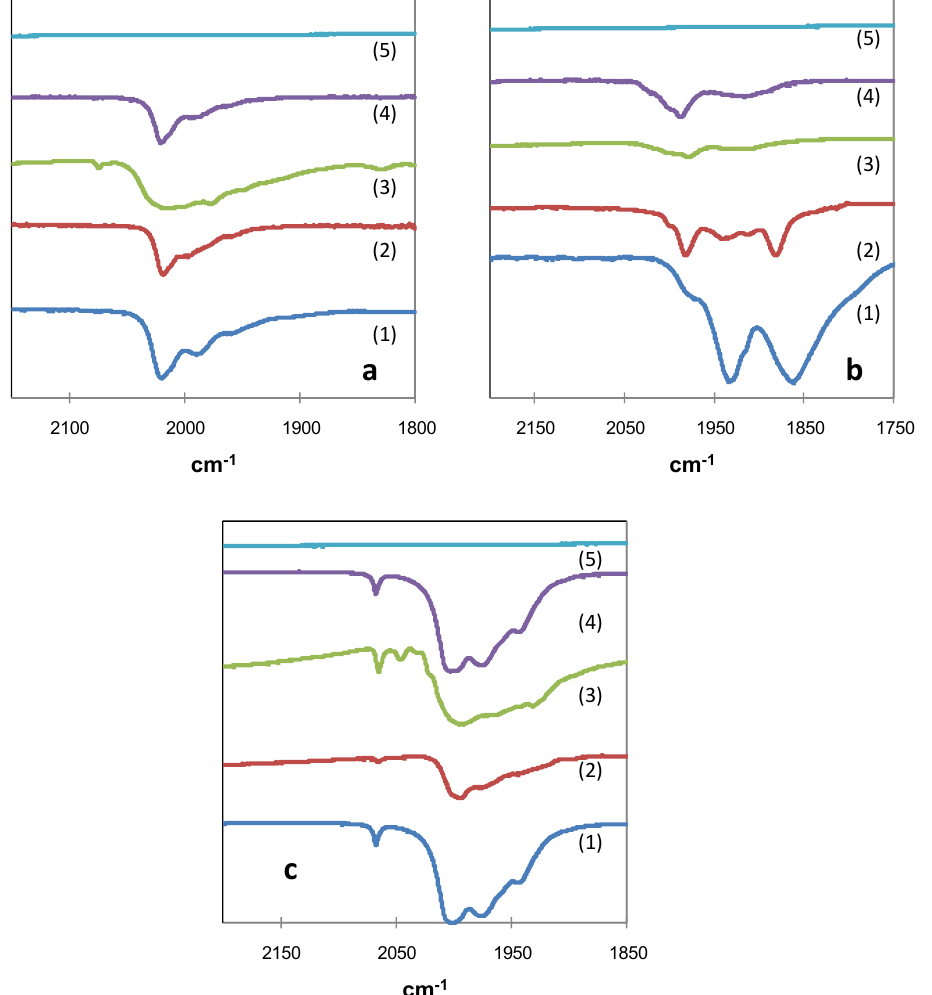
Figure 1. FTIR spectra in the ν (CO) region obtained during catalyst